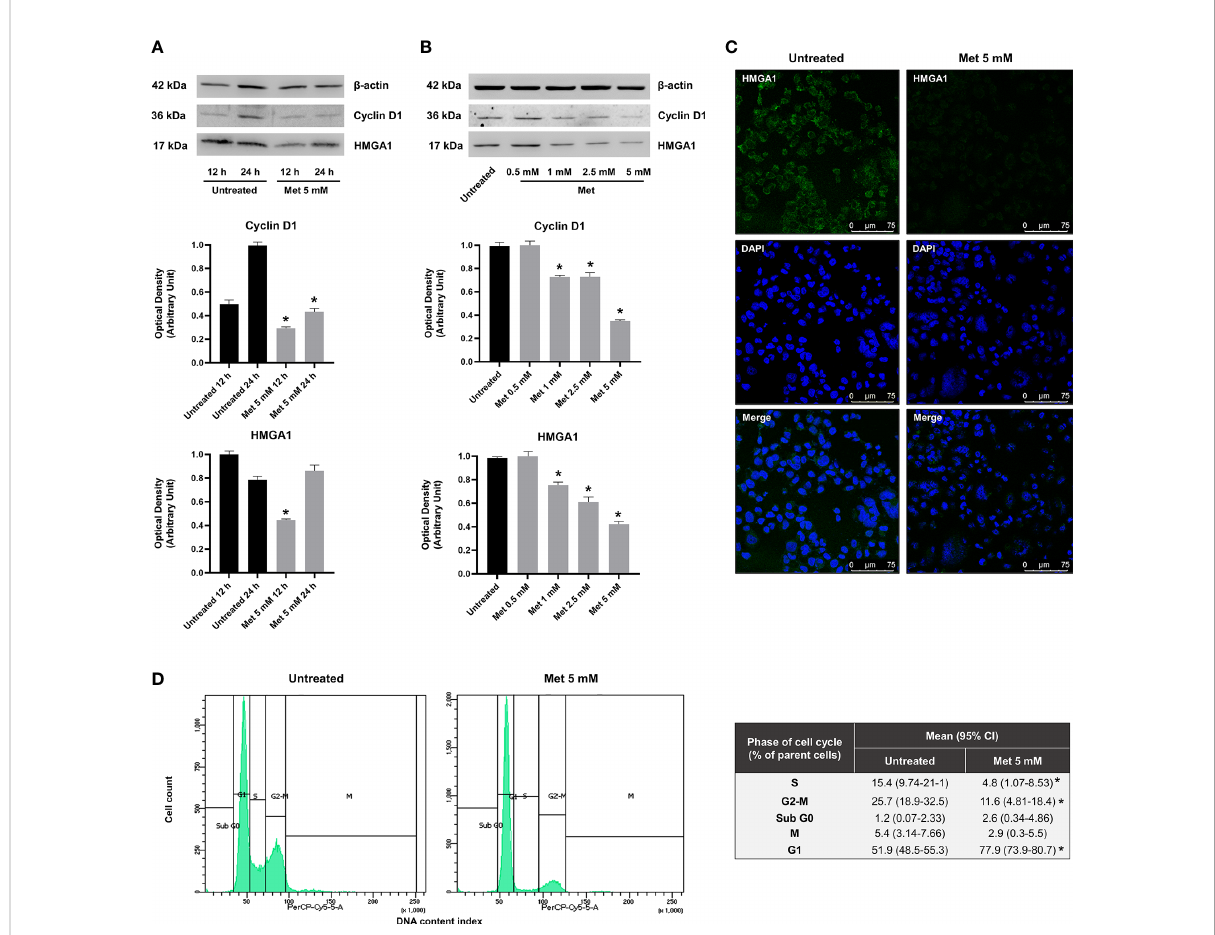
FIGURE 4 (A) Representative immunoblots of time-course experiments documenting a reduced expression of nuclear protein factors involved in cell cycle regulation (HMGA1 and cyclin D1) following 12 h and 24 h treatment with Met 5 mM in SEM-1 cells. * p < 0.05 vs untreated cells (black bars) at each time point. (B) Representative immunoblots documenting a dose-dependent reduced expression of HMGA1 and cyclin D1 following 12 h treatment with Met concentrations equal or lower than the IC 50 (0.5 to 5 mM). * p < 0.05 vs untreated cells (black bars). (C) Immuno fl uorescence assay was performed to map HMGA1 (green fl uorescence) in SEM-1 cells following 12 h treatment with Met 5 mM. Nuclear staining was performed with DAPI dye (blue fl uorescence). Representative confocal images. Scale bar: 75 µm. (D) Distribution of cell cycle phases by PI staining in fl ow cytometry following 24 h treatment with Met 5 mM. Cell distribution across the phases of cell cycle was compared using the Chi-square test. * p < 0.05 vs untreated